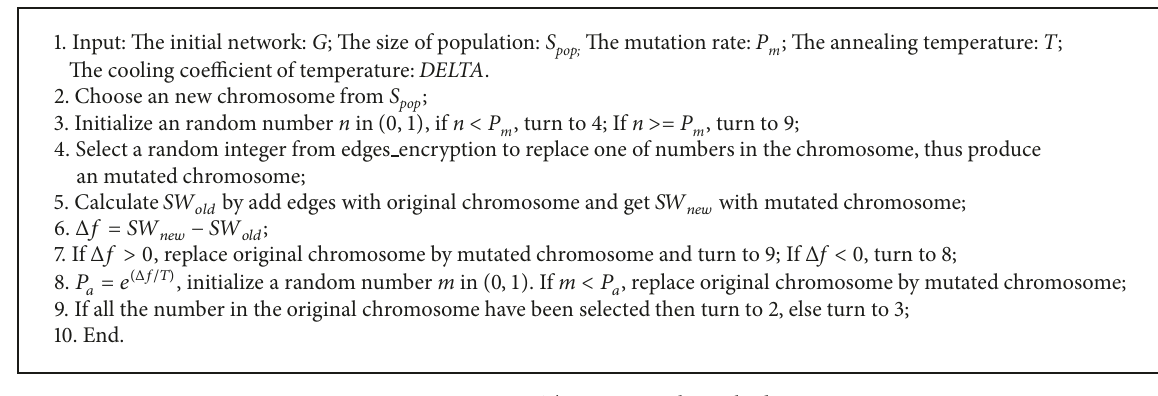
Algorithm 2: The Monte Carlo method.